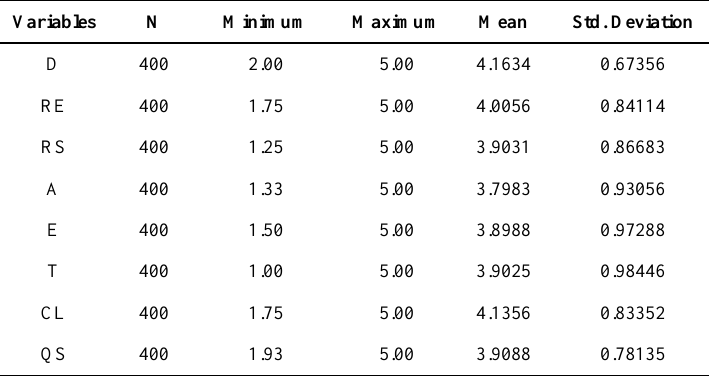
Table 2. Descriptive statistics for research